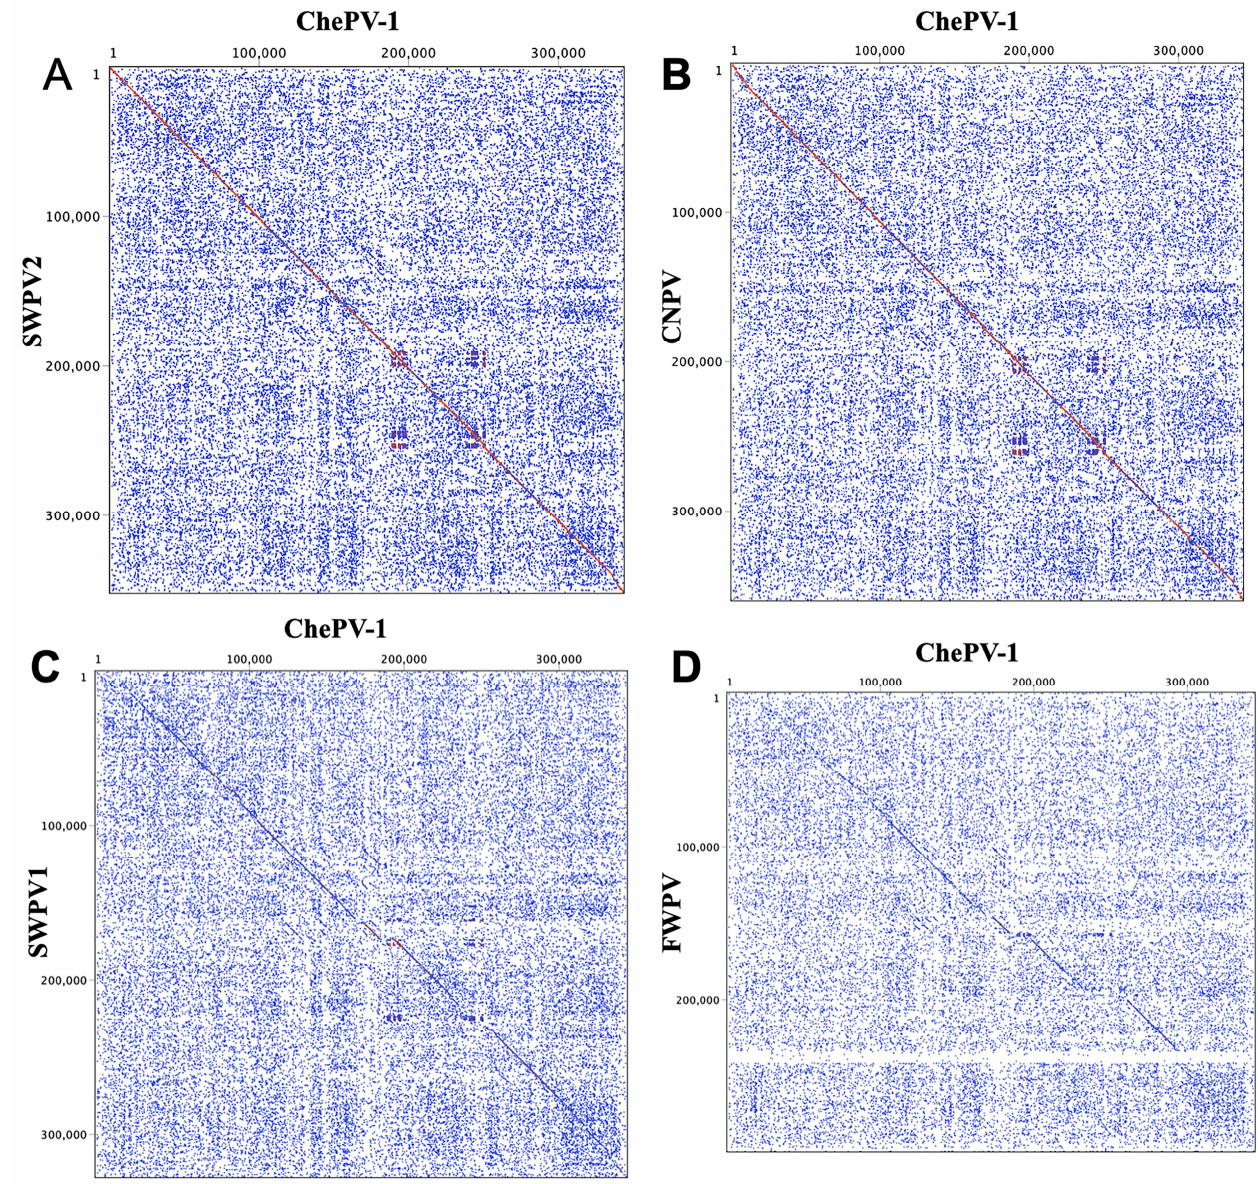
Figure 3. Dot plots of the ChePV-1 genome (x-axis) vs. other selected sequenced poxvirus genomes (y-axis). ( A ) ChePV-1 vs SWPV2, ( B ) ChePV-1 vs canarypox virus (CNPV) ( C ) ChePV-1 vs shearwaterpox virus-1 (SWPV1) and ( D ) ChePV-1 vs fowlpox virus (FWPV). The Classic color scheme was chosen in Geneious (version 10.2.2) for the dot plot lines according to the length of the match, from blue for short matches, to red for matches over 100 bp long. Window size = 12.